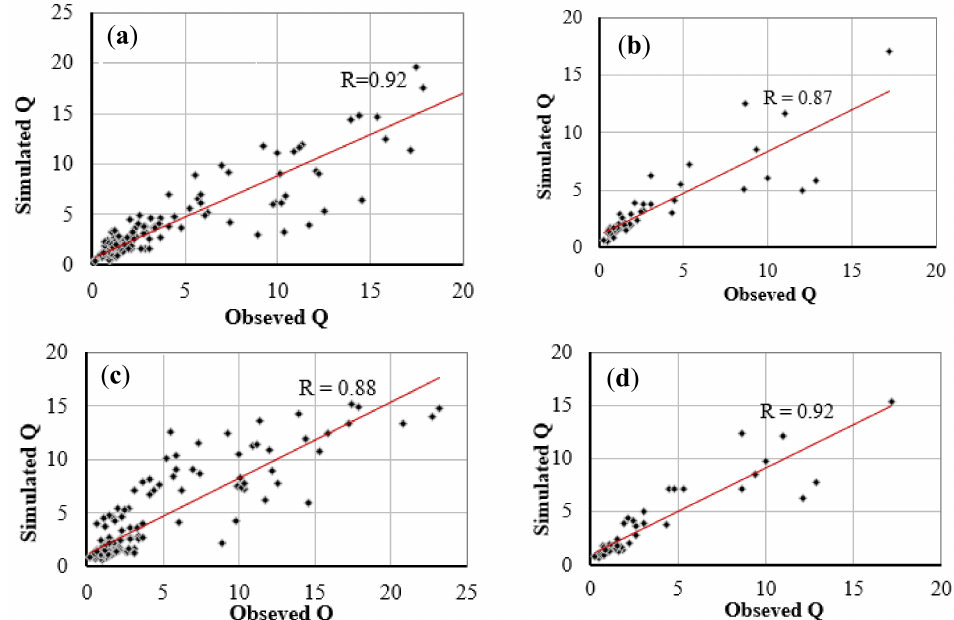
Figure 6. Performance of SVR-Quadratic and KNN (the worst and best techniques) in terms of correlation coefficient for Alavian Basin: ( a ) SVR-Quadratic_training data; ( b ) SVR-Quadratic_verification data;